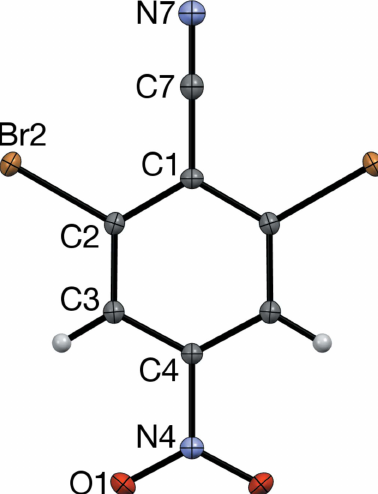
Figure 1 The molecular structure of (I), showing the atomic numbering and displacement ellipsoids at the 50% probability level. Unlabelled atoms are related by twofold and mirror symmetry.